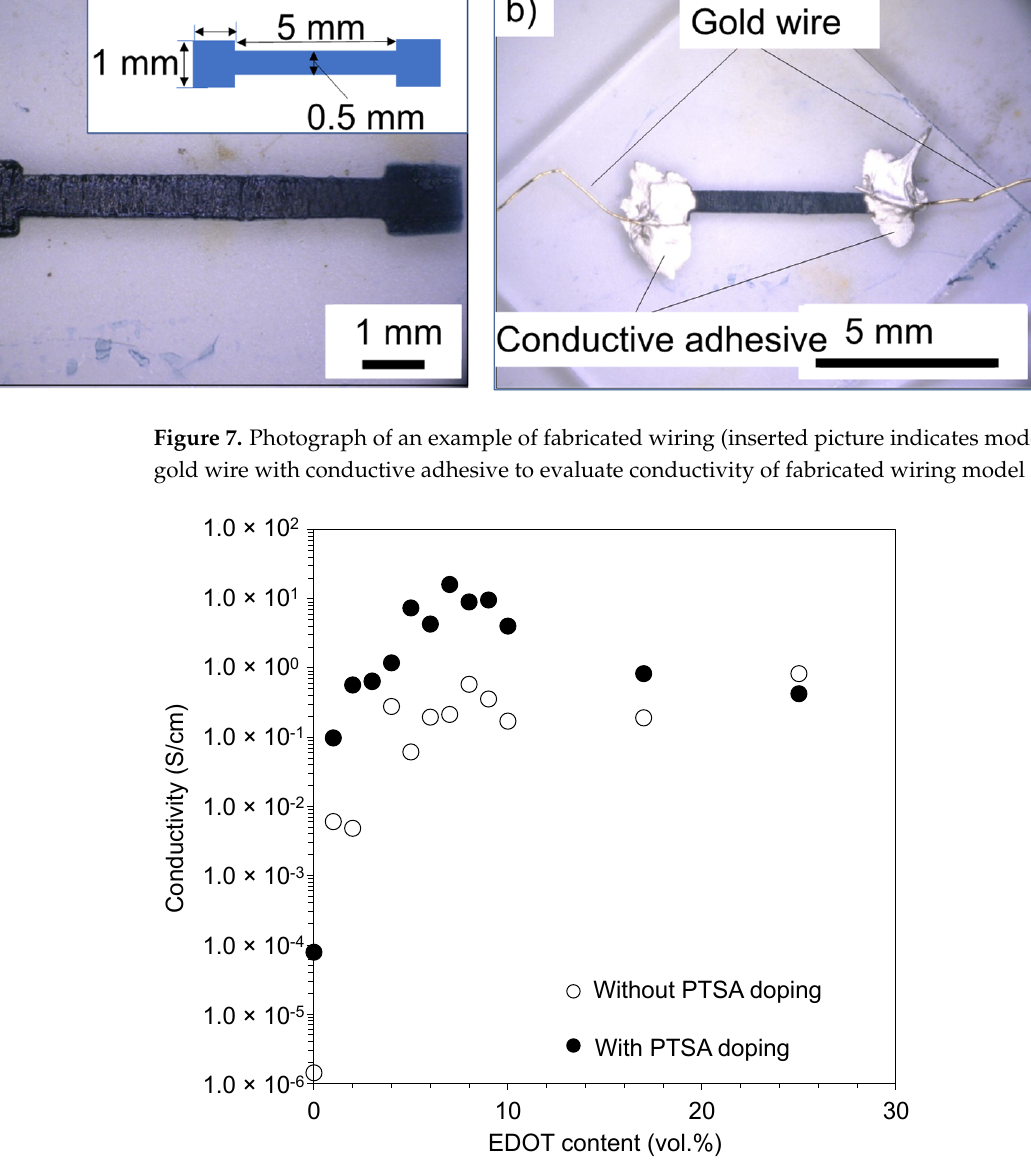
Figure 8. Electrical conductivity of fabricated wiring before (open circles) and after (closed circles) PTSA doping.